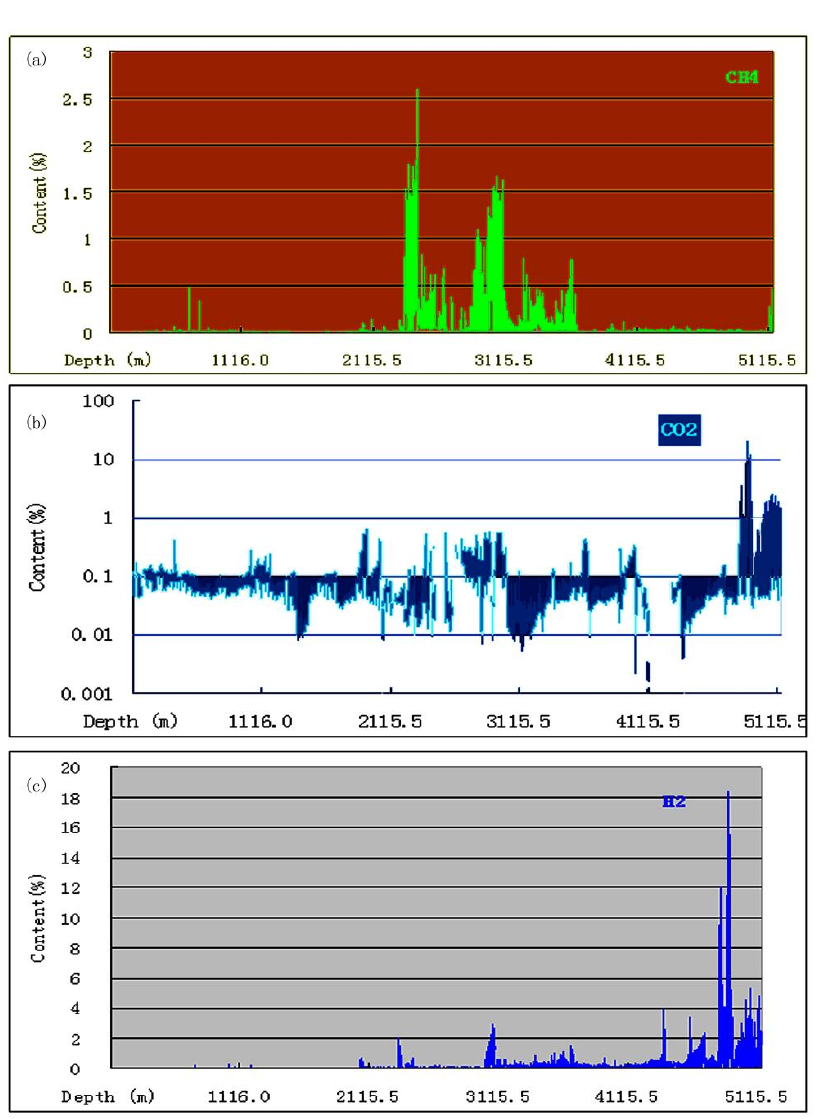
Figure 2. The gas anomaly records observed during the CCSD drilling: ( a ) methane, ( b ) carbon dioxide, and ( c ) hydrogen.